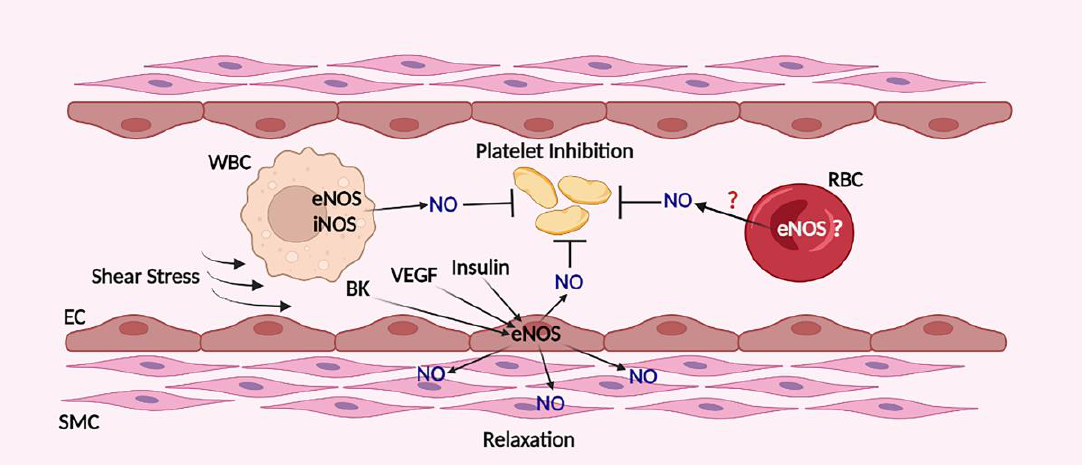
Figure 1. Sources of NO in blood vessels. The main source of NO in blood vessels is endothelial cells that express eNOS, which is activated by different stimuli including shear stress, bradykinin (BK), VEGF, insulin and other stimuli that could increase intracellular calcium concentration. White blood cells (WBC) produced NO by the activity of eNOS and iNOS also involved in platelet inhibition. The questions whether erythrocytes (RBC) also express functionally active eNOS and whether they could produce NO which reaches platelets are still not clear.